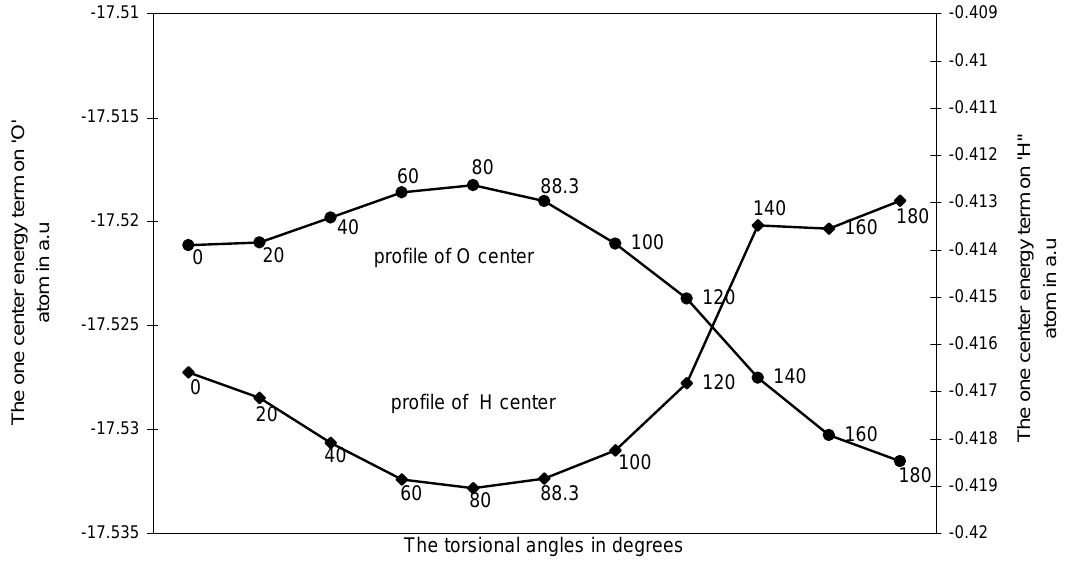
Figure 7. Plot of the one-center energy terms on 'O' and 'H' atoms of hydrogen peroxide as a function of torsional